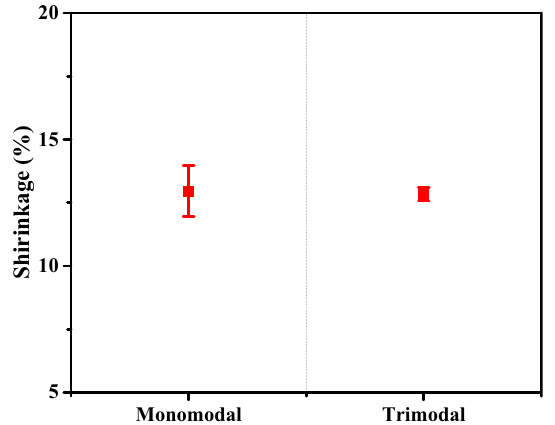
Figure 13. Comparison of dimensional shrinkage of 70 vol. % sintered specimens using trimodal vs. monomodal powder (average value was taken for shrinkage of height, thickness, and outer diameter for each